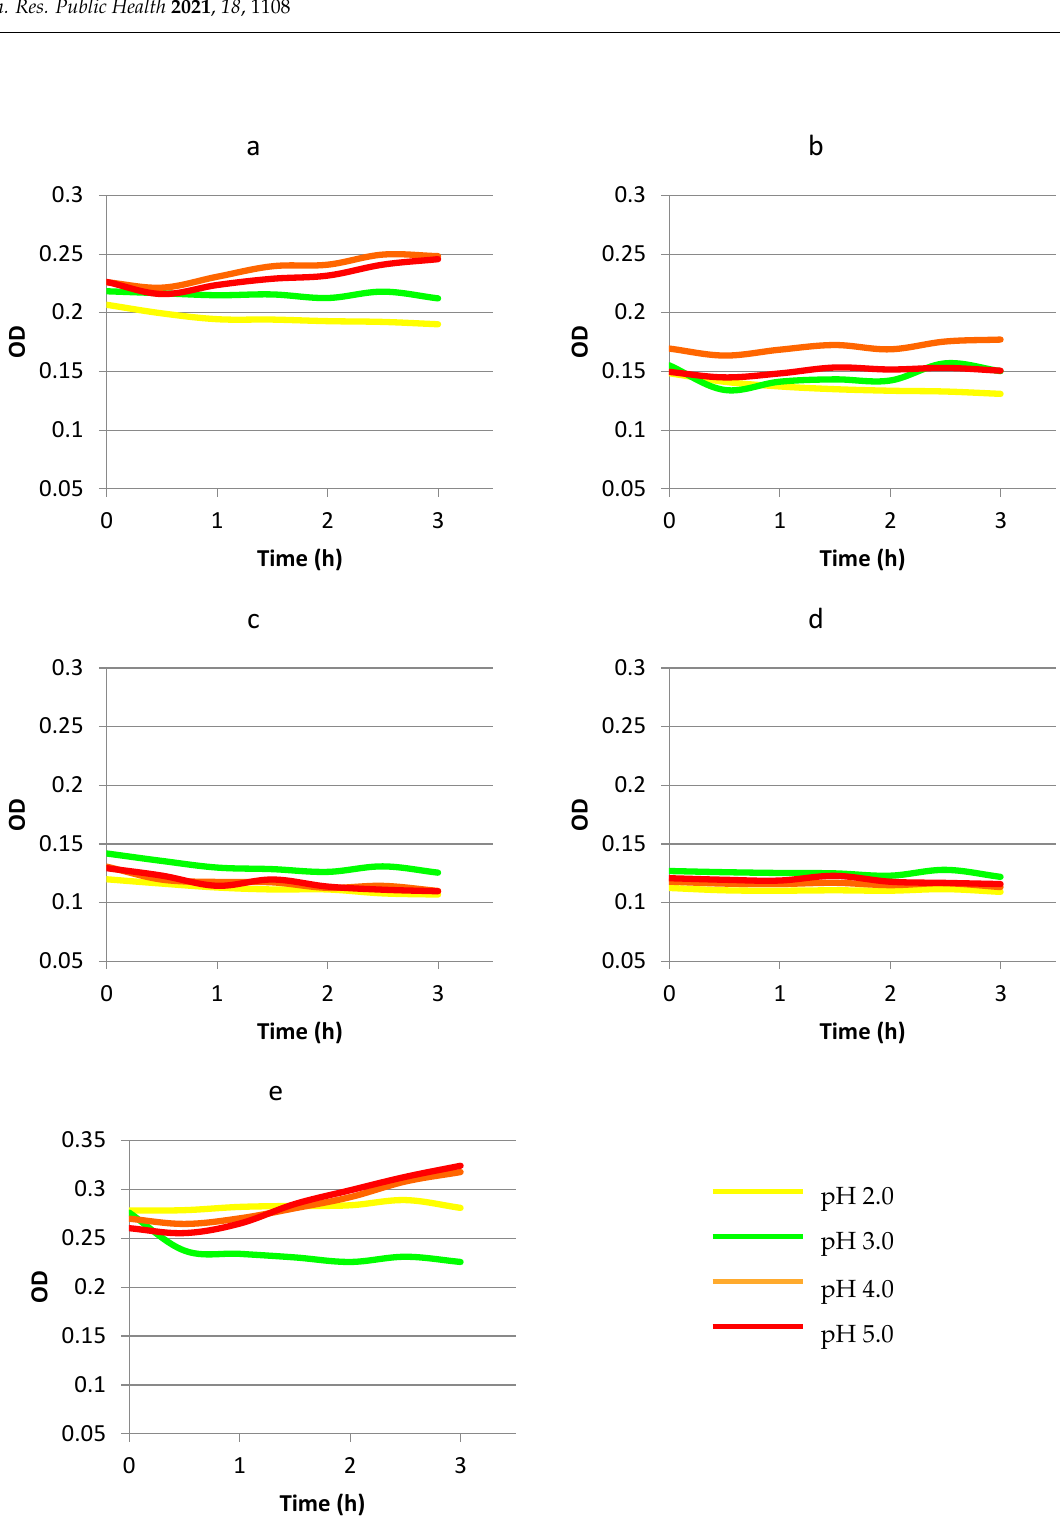
Figure 4. Changes in the optical density during culture of commercial probiotic strains in the food matrix under simulated condition of the gastric passage ( a ) Lb. rhamnosus GG ATCC 53103; ( b ) Bifidobacterium BB-12; ( c ) Lb. casei ; ( d ) Lb. acidophilus ; ( e ) Lb. plantarum , ( p < 0.05). The number of repeats for each treatment n = 3. Letters marked with the same color define a homogeneous group within one pH value among the tested variants of the experiment (a given color correlates with the pH value and a given letter correlates with a given homogeneous group within pH range). Gastric fluids differed in pH values, which were higher at the beginning and lower at the end of digestion. Optical density of the culture of the Lb. GG strain decreased insignificantly at pH 2.0 and 3.0. Already active acidity of 4.0 and 5.0 enabled the growth